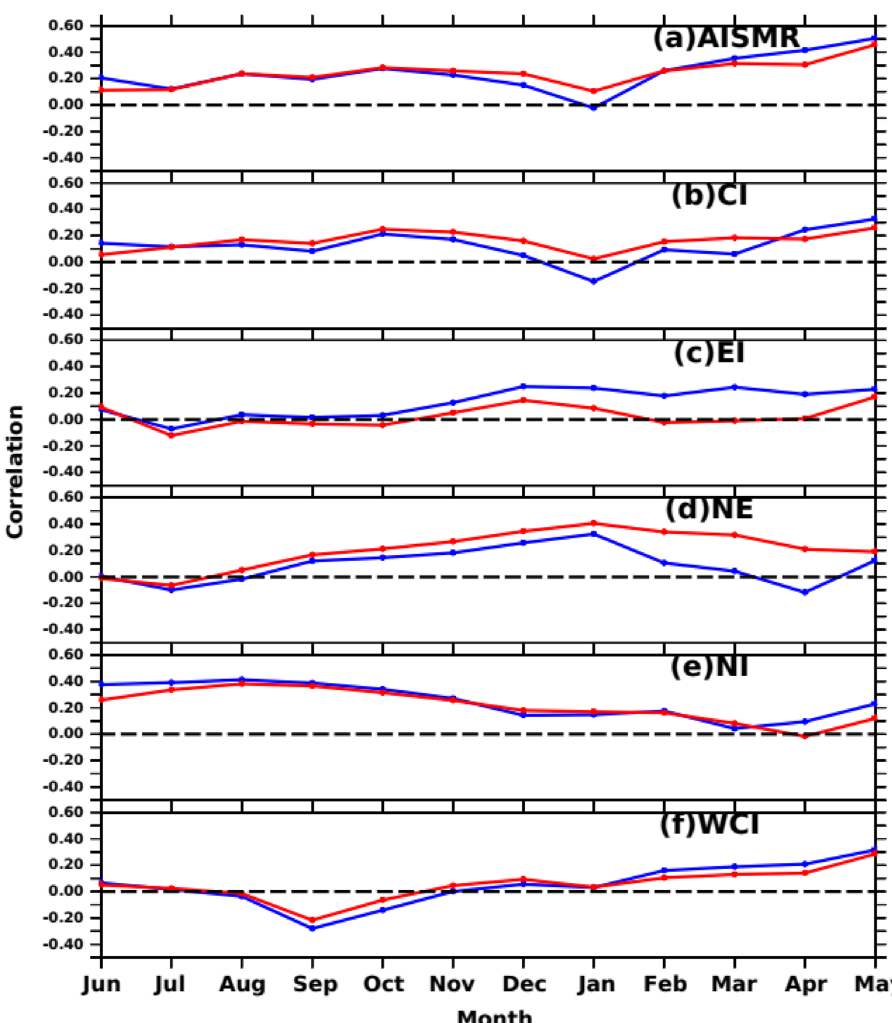
Figure 12. Time series of lagged correlation between detrended MSLA over SWIO and detrended regional rainfall (SAI) over the five homogeneous regions and entire Indian landmass before (red) and after (blue) removing ENSO effect. The figure is generated using PyFerret v7.63.